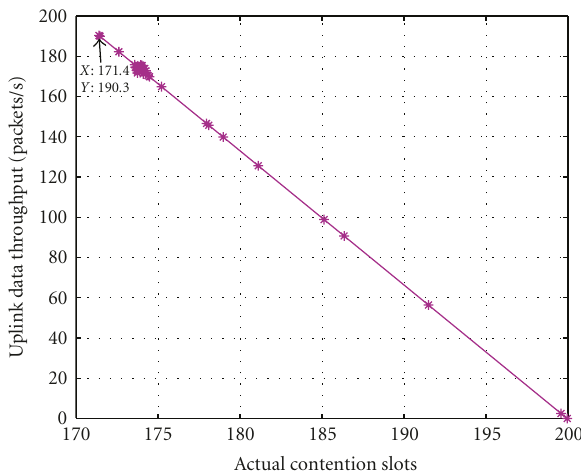
Figure 9: The uplink throughput with variable contention slots, V = 10.